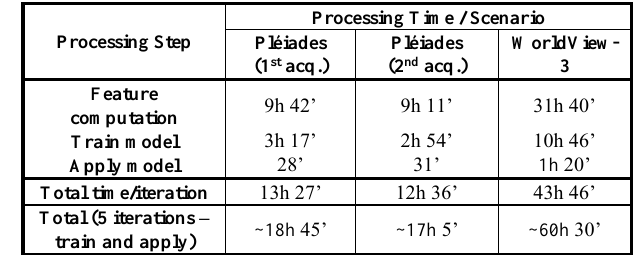
Table 5. Processing times for classification